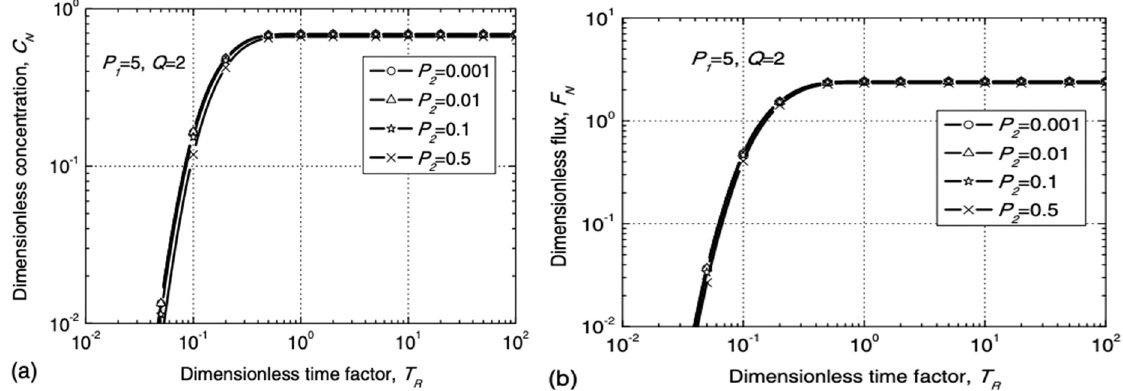
Figure 7. Variation curve of C N and F N of pollutant with P 2 ( P 1 = 5, Q = 2): ( a ) dimensionless concentration C N ; ( b ) dimensionless flux F N . Reprinted with permission from Ref. [15], Copyright 2018 ASCE Library.